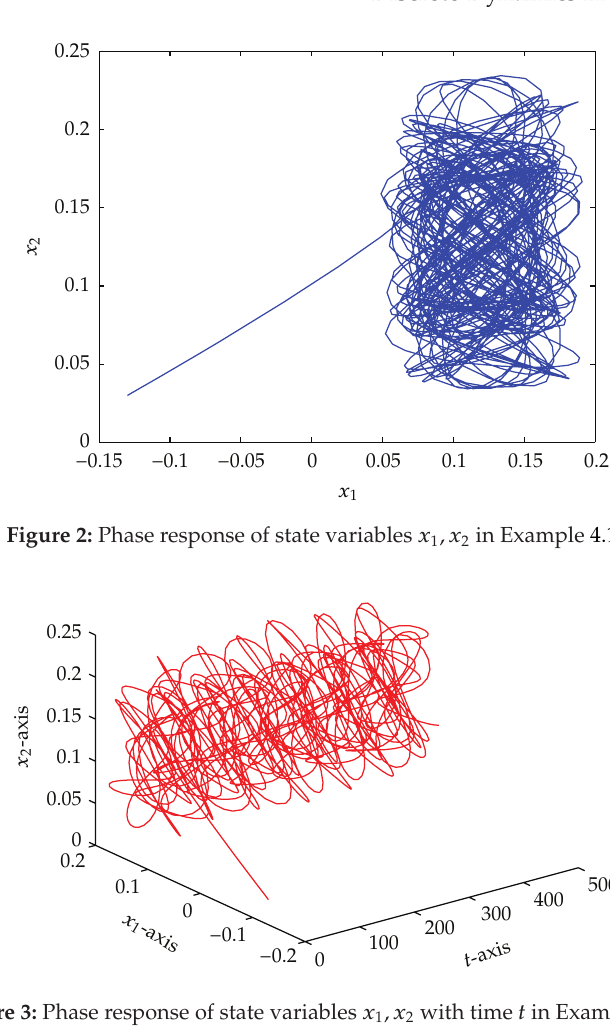
Figure 3: Phase response of state variables x 1 ,x 2 with time t in Example